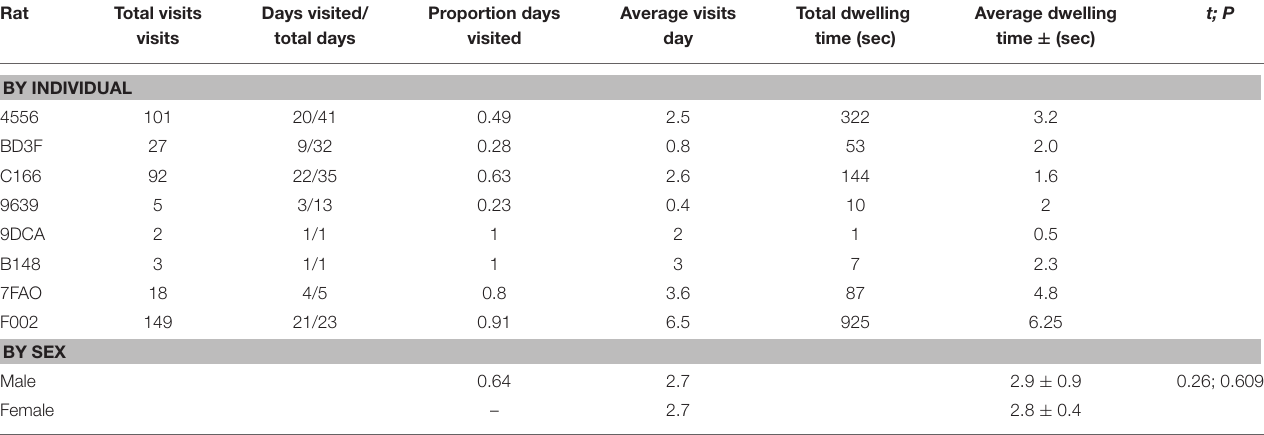
A06E M F002 M 256 BY SEX Male 9/1 Female 4/1